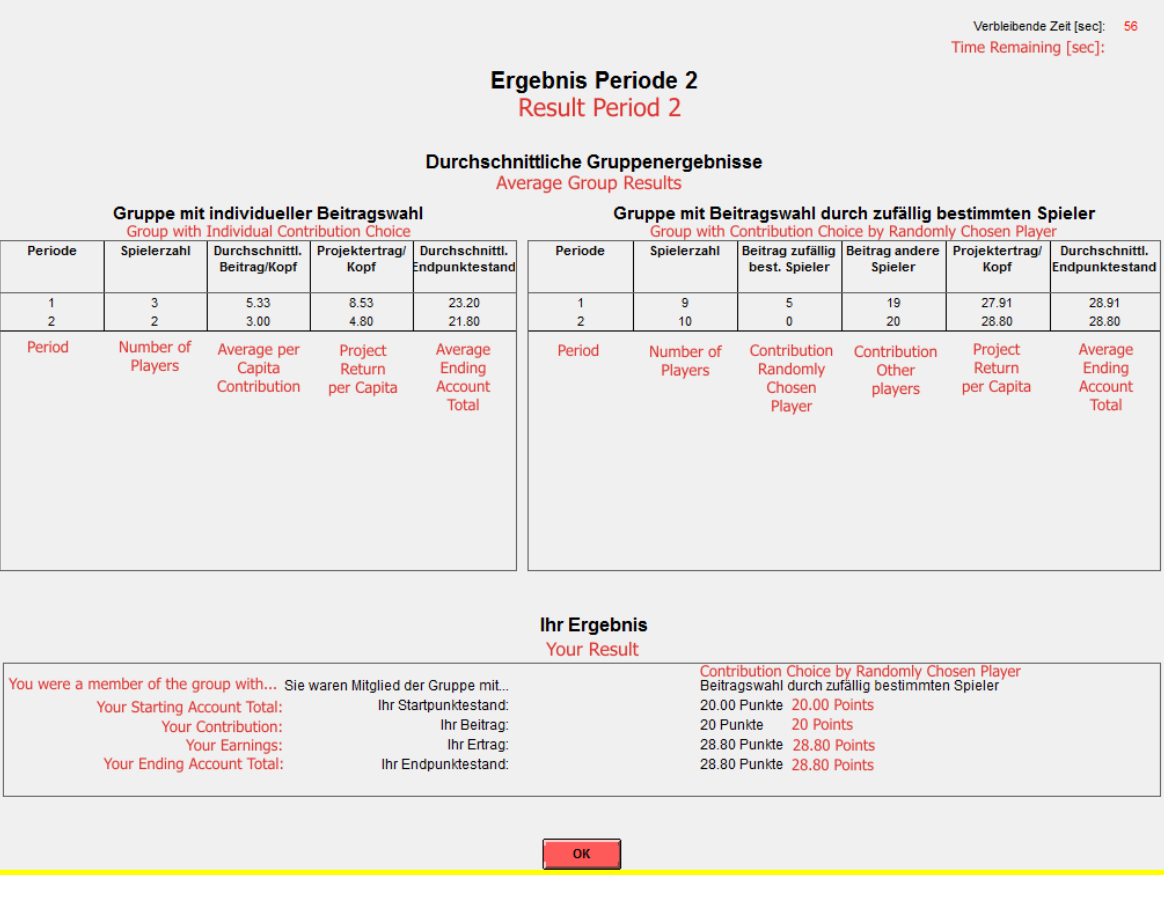
Figure 2. Example dictator treatment results screen. The figure displays an example of the results screen as shown to subjects at the end of each period in the dictator treatment.